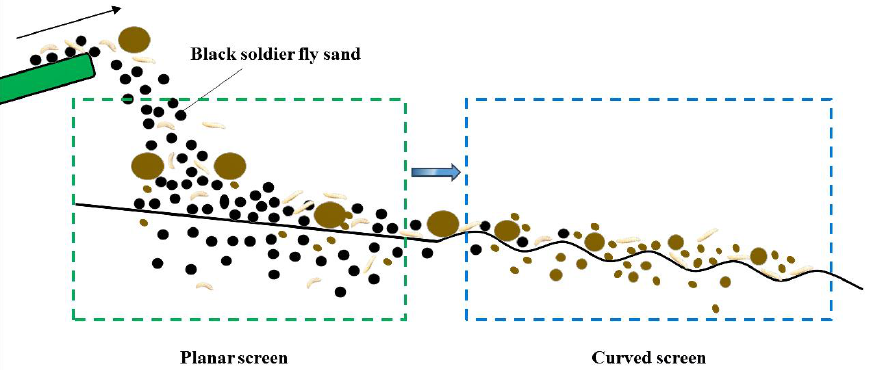
Figure 2. Schematic diagram of two-stage sieve surfaces separation.